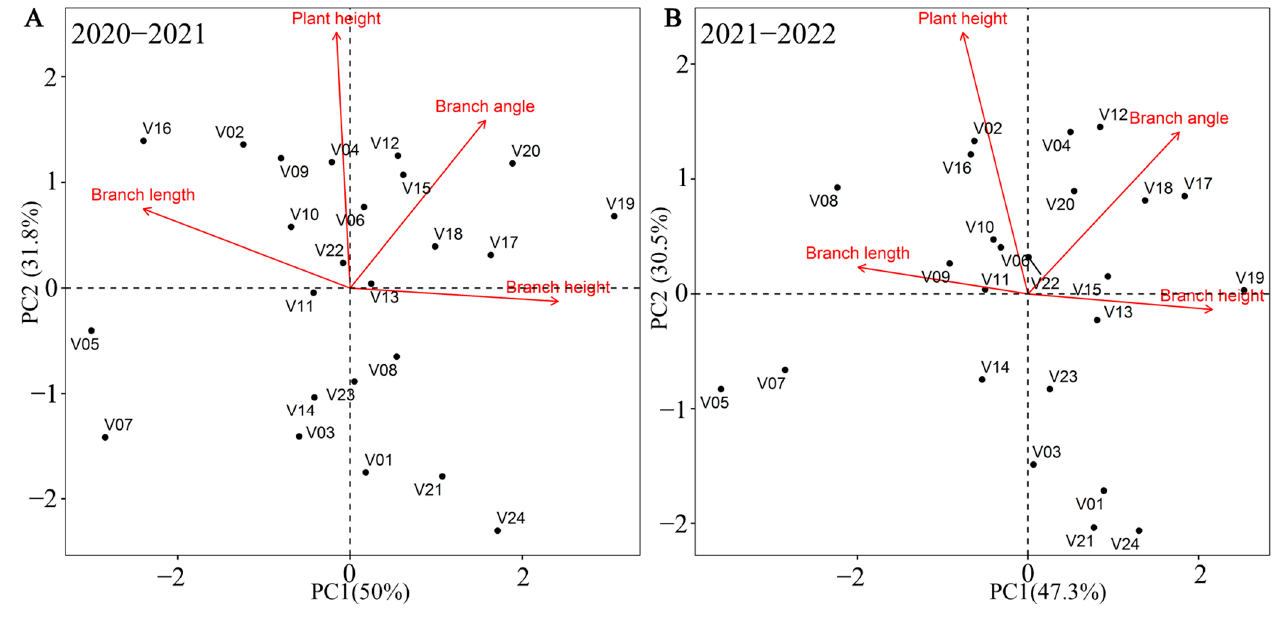
Figure 5. PCA-Biplot for the plant architecture traits of the growing seasons 2020–2021 ( A ) and 2021– 2022 ( B ). BL, branch length; BA, branch angle; PH, plant height; RBH, relative branch height.